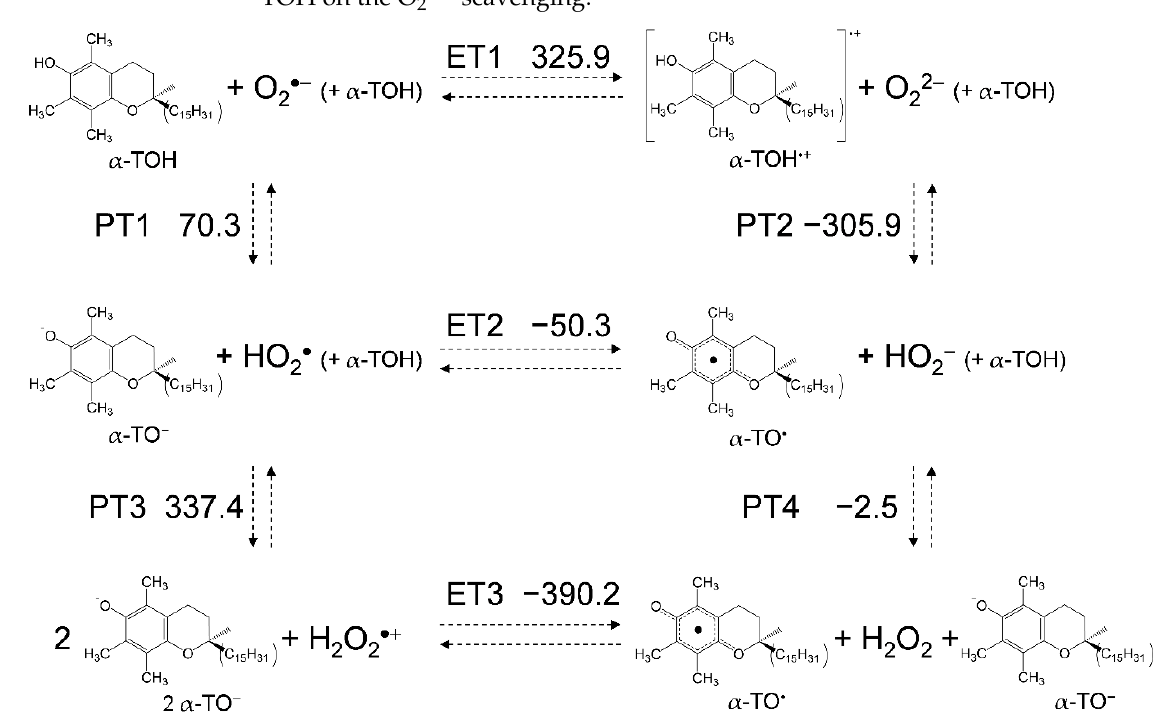
Figure 5. Six diabatic electronic states and the ∆ G ◦ values for PCET between α -TOH and O 2 •− involving two PTs and one ET in DMF. The ∆ G ◦ (kJ mol − 1 , 298.15 K) for the (PT1-PT4) and ET (ET1-ET3) were calculated using the DFT-(U)B3LYP/PCM/6-311+G(d,p) method.